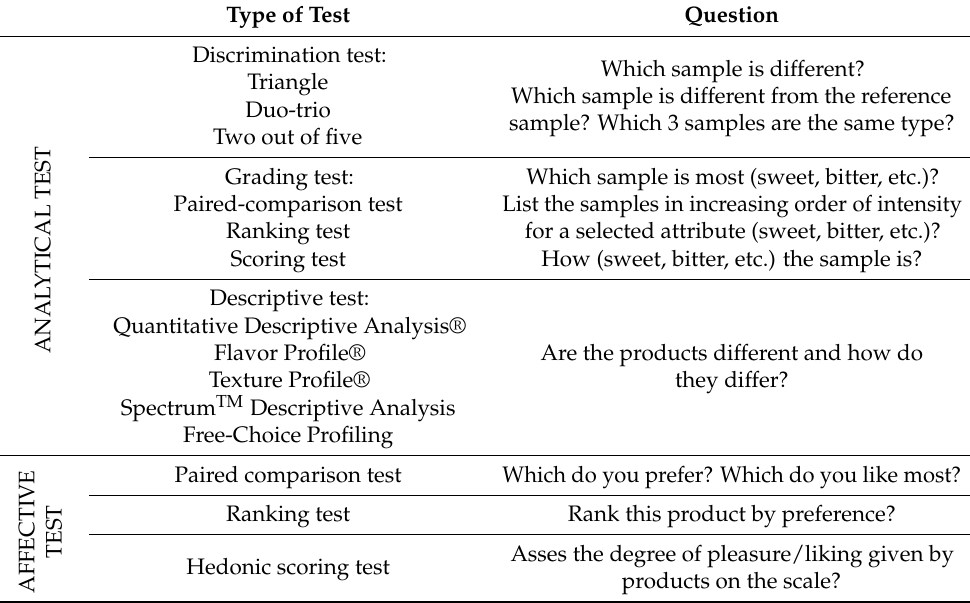
Table 1. Types of most popular analytical and affective tests used in sensory